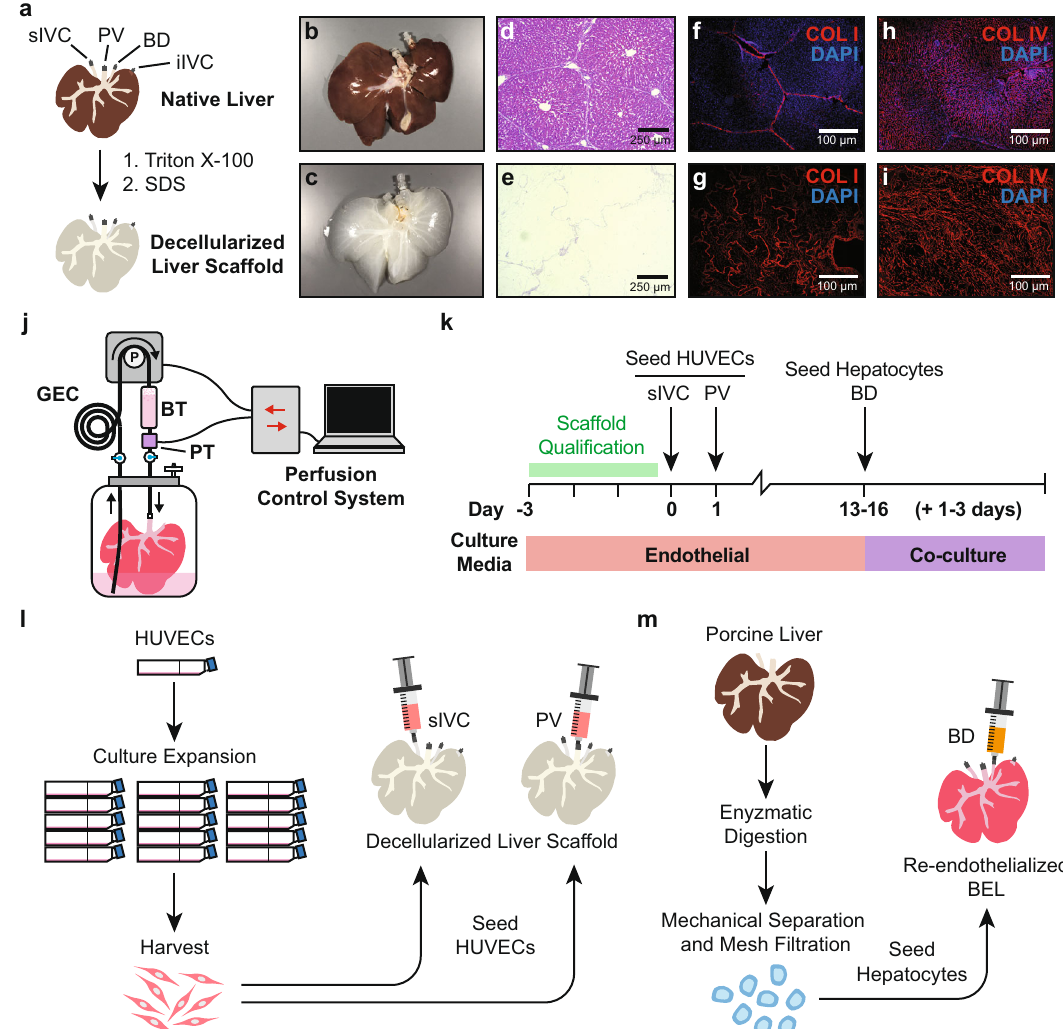
Fig. 1 Overview of approach to bioengineering a porcine-derived whole liver construct. a Overview of vessel cannulation and detergent perfusion methods for whole liver decellularization. b , c Photographs of representative porcine ( b ) native and ( c ) decellularized whole livers. d , e Hematoxylin and eosin staining of histological sections from ( d ) native and ( e ) decellularized porcine liver tissue demonstrating the ef fi cient removal of cellular material while preserving the native tissue architecture. f – i Representative immuno fl uorescence micrographs from native ( f , h ) and decellularized ( g , i ) liver tissue demonstrating retention of Collagen I and Collagen IV, respectively, in cell-free scaffolds. The absence of DAPI staining in the decellularized scaffolds demonstrates removal of cellular DNA. j Schematic of perfusion bioreactor design. BELs are suspended in a vessel with culture media. An extended coil of silicone tubing (GEC) is included in the perfusion circuit to facilitate gas exchange. A bubble trap is positioned directly upstream of the BEL perfusion inlet. During media perfusion, a pressure transducer provides real-time feedback to a controller which in turn adjusts the fl ow rate on a peristaltic pump to maintain a constant perfusion pressure. k Schematic depicting bioreactor culture and cell seeding events. Decellularized scaffolds were pre-quali fi ed in antibiotic-free media for 3 days prior to HUVEC seedings. HUVEC-seeded liver constructs were cultured in endothelial cell growth media until a 24 h average glucose consumption rate of 50 – 90 mg/h was reached (typically 13 – 16 days), at which point hepatocytes were seeded into the scaffold. BELs